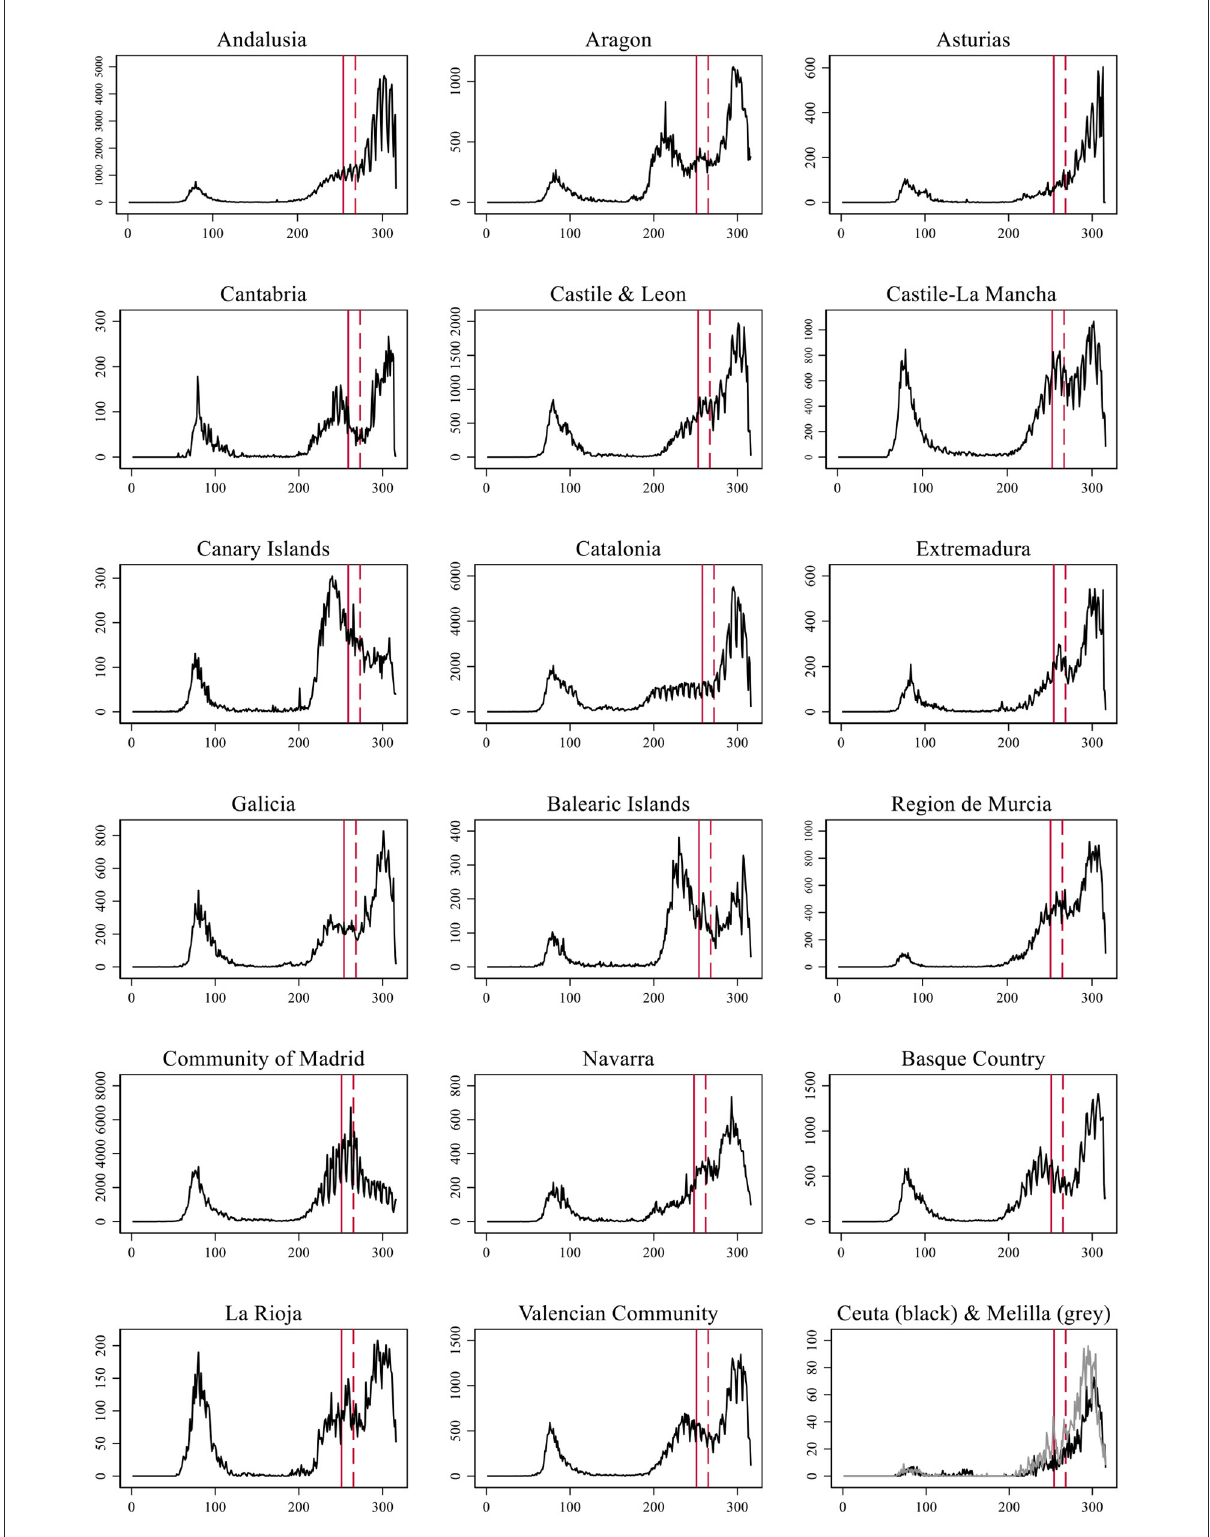
FIGURE1 Evolution of the number of COVID-19 cases per day in each Autonomous Community of Spain.